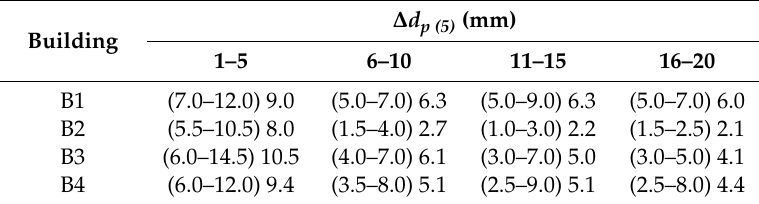
Table 3. The list of the penetrometer test results.